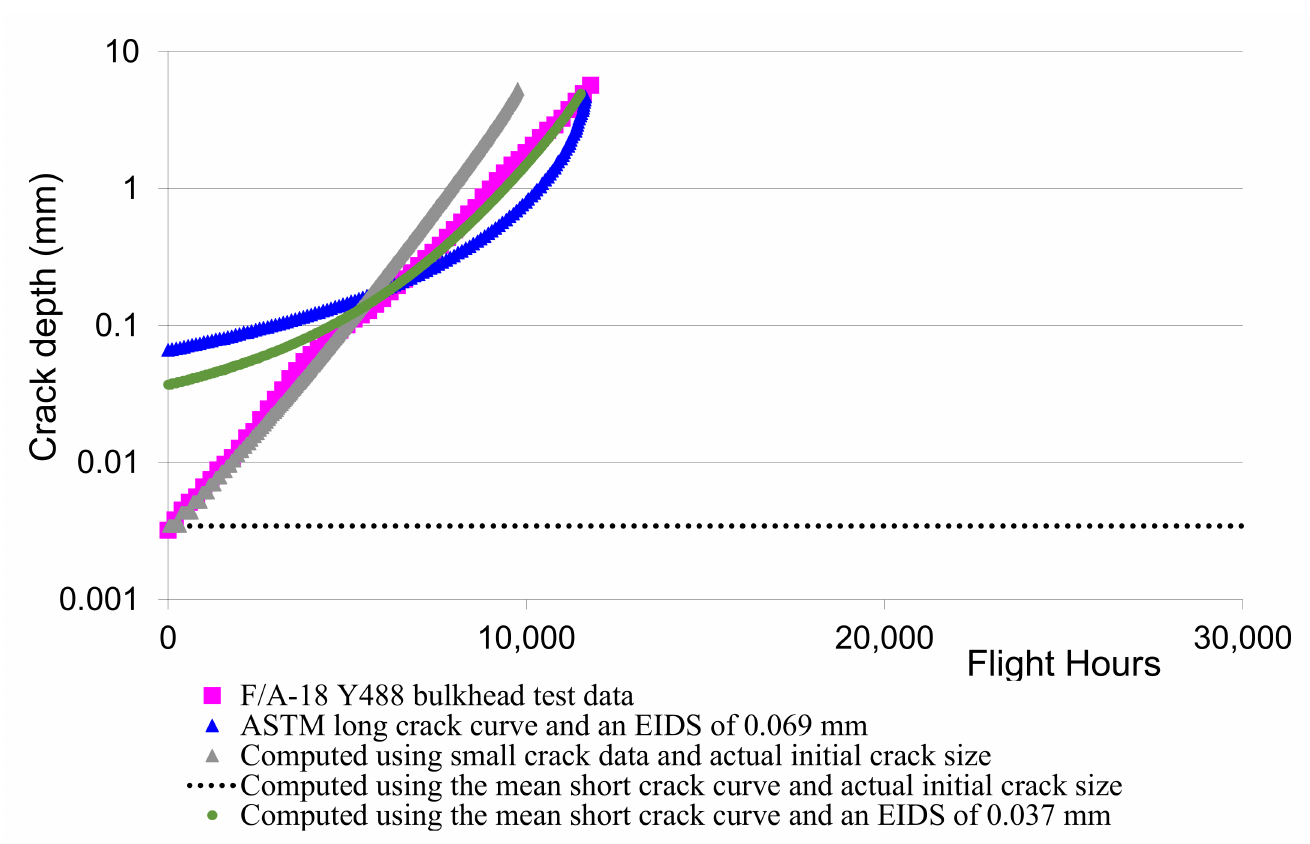
Figure 1. The measured and computed crack growth histories obtained using different da / dN versus ∆ K curves and the associated (different)